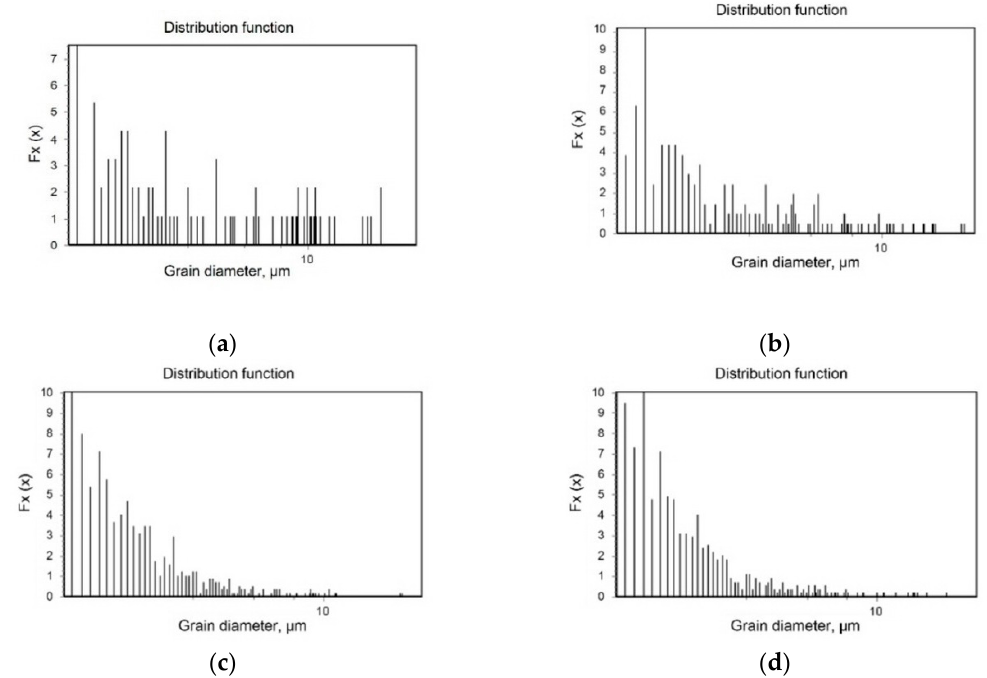
Figure 5. The effect of the static load in UNSM treatment on the grain diameter distribution of Alloy 600 determined from the EBSD area of Figure 4: ( a ) untreated; ( b ) 10 N; ( c ) 30 N; ( d ) 50 N.